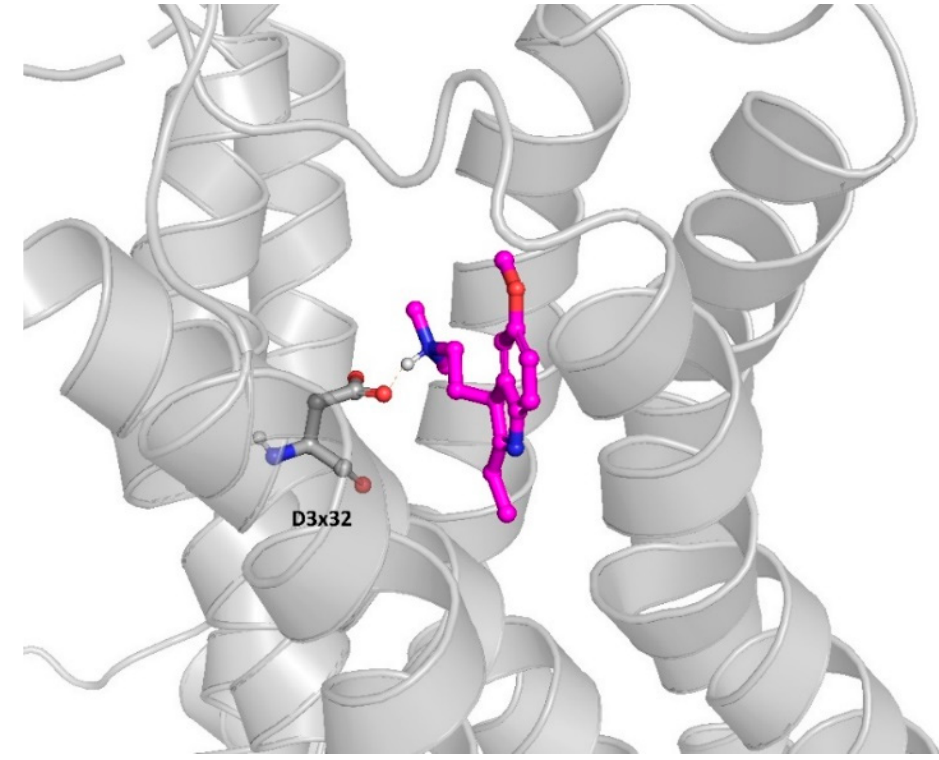
Figure 4. 5-HT 6 R ligand (CHEMBL267615) docked to the 5-HT 6 R homology